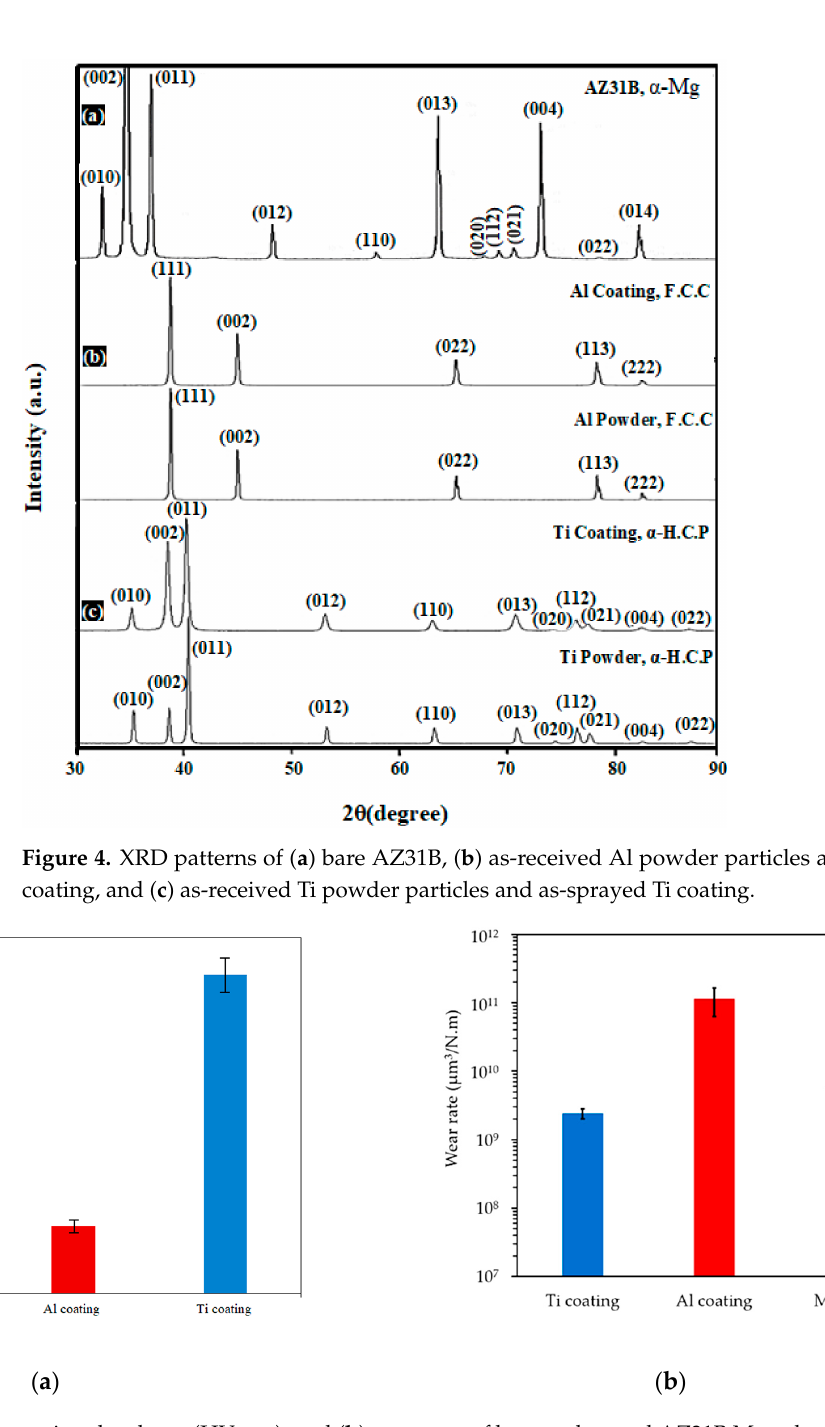
Figure 5. ( a ) Average micro-hardness (HV 0.025 ); and ( b ) wear rate of bare and coated Mg substrates.